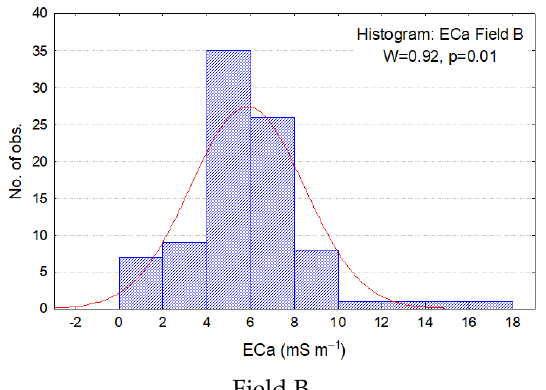
Figure 4. Semivariograms, cross-validation plots, and maps of spatial variability of ECa for the two fields selected. Adjustment parameters of the semivariograms: C 0 : Nugget effect; C 0 +C: Level; a: Range (m); r 2 : coefficient of determination. Cross-validation parameters: RC: regression coefficient; y: intercept; SEP: standard error of prediction; r 2 : coefficient of determination. Cachoeira do Sul, RS.